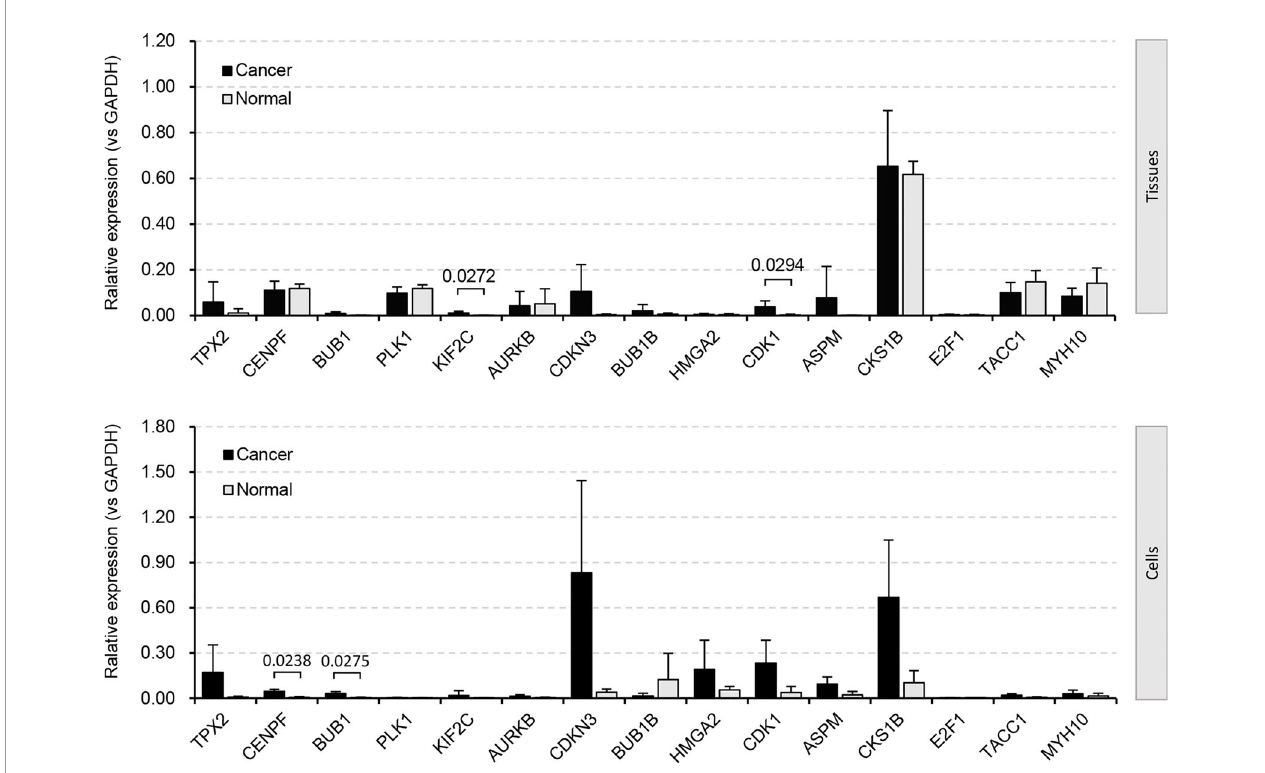
FIGURE 3 | DEGs validated by qRT-PCR experiment. Four biological repetitions were applied to patient tissues; two biological repetitions and two technical repetitions were applied to cell lines. Human tumor-adjacent tissues and lung fi broblast cells (MRC-5) were used for control,